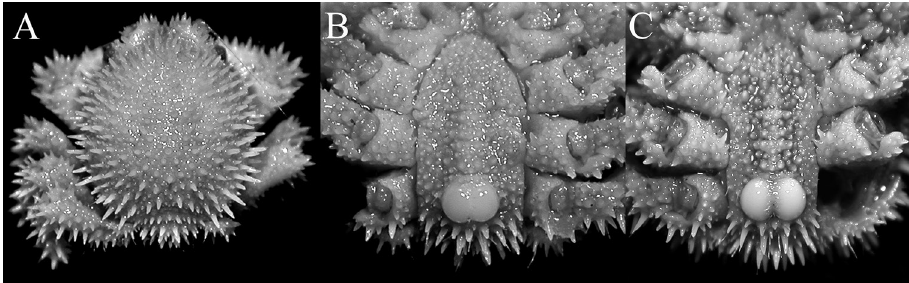
Figure 3. Acanthodromia margarita (Alcock, 1899). A , B male (11.6 × 12.0 mm) (ZRC 2003.668), Philippines C , male (13.5 × 14.2 mm) (ZRC 2004.596), Philippines. A overall dorsal view B, C pleon showing tubercles on somite